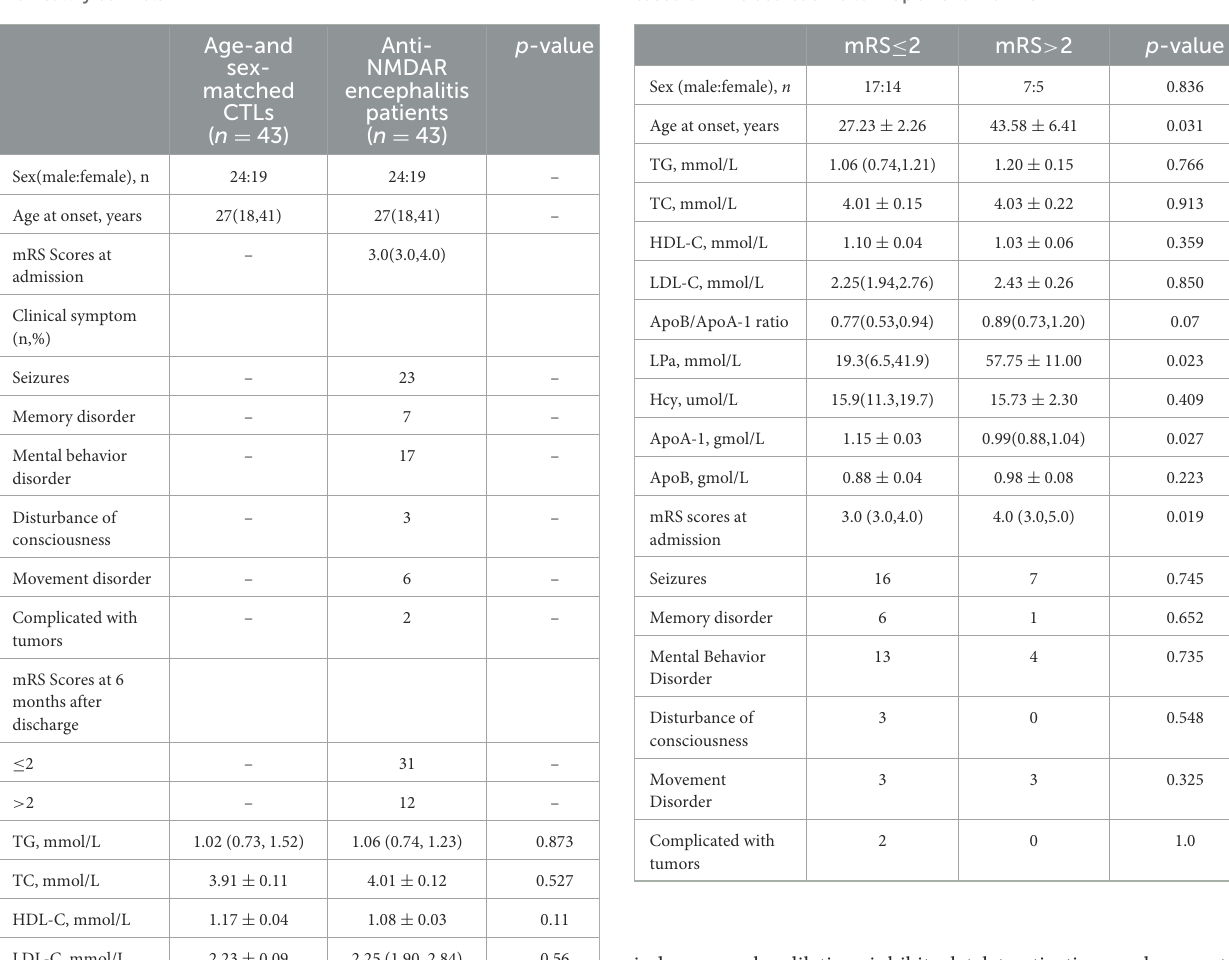
TABLE 2 Subgroup comparison of anti-NMDAR encephalitis patients based on mRS Scores at follow-up after 6 months.